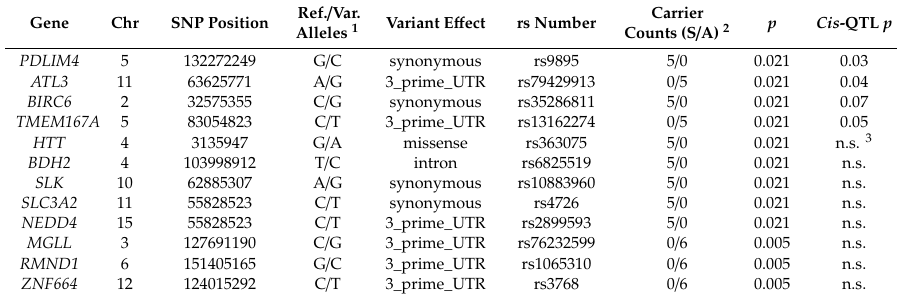
Table 2. Selected candidate SNP information obtained by RNA-Seq SNP data analysis (n = 14; 7 asymptomatic and 7 symptomatic patients) 1 Ref. allele: allele in the reference sequence; Var. allele: variant allele observed in the sample. 2 Carrier counts in symptomatic (S) and asymptomatic (A) patients of the variant allele. 3 n.s.: not